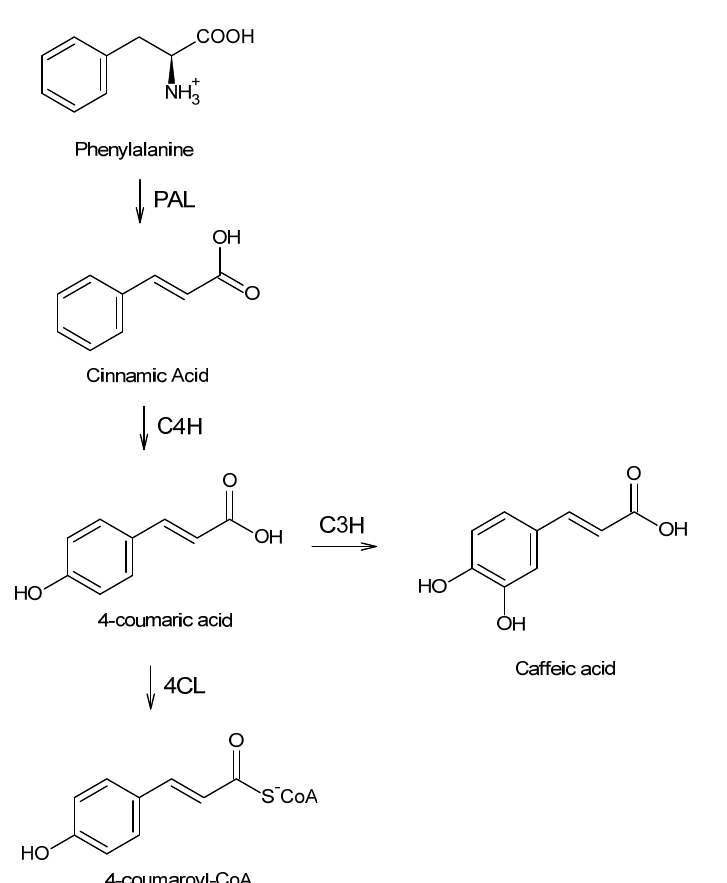
Figure 2. Phenylpropanoid pathway [58].